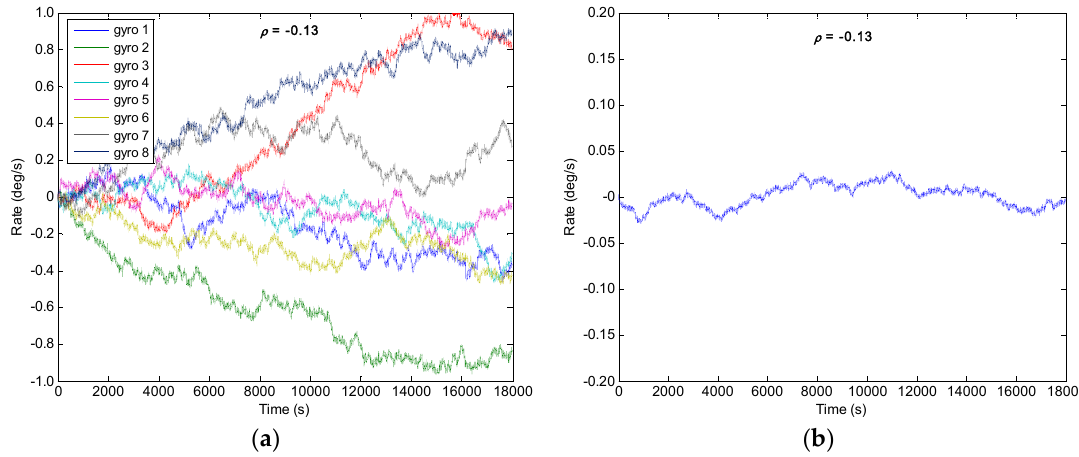
Figure 7. Filtering result of gyroscope array with ρ = − 0.130: ( a ) Outputs of component gyroscopes; ( b ) Output of combined gyroscope.